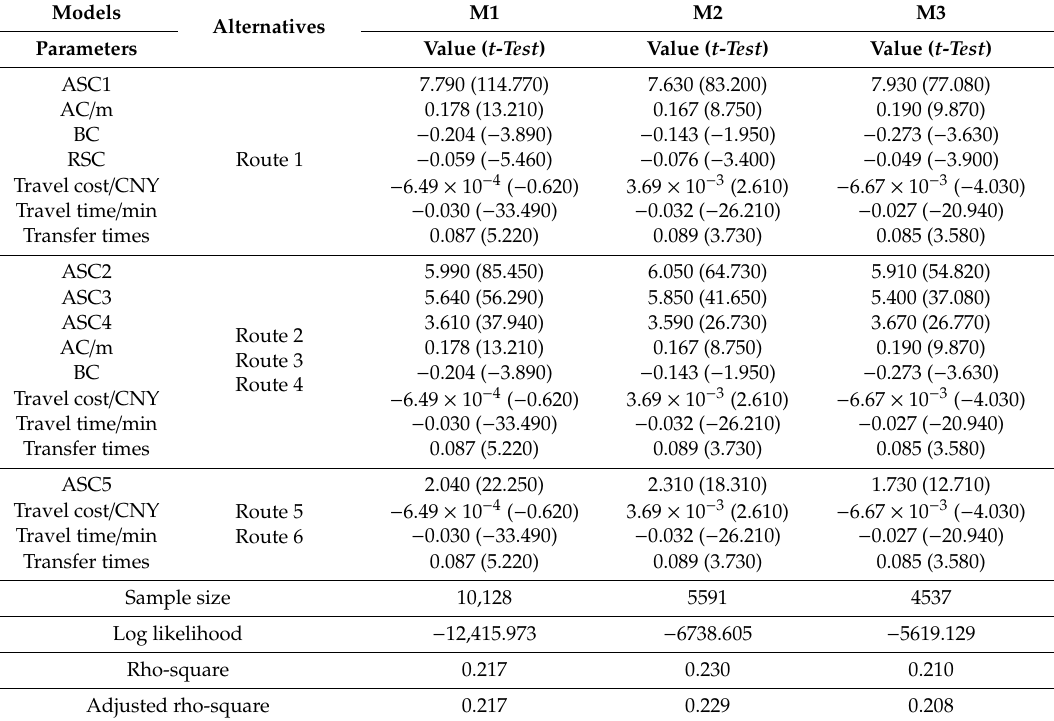
Table 2. Estimation results of route choice